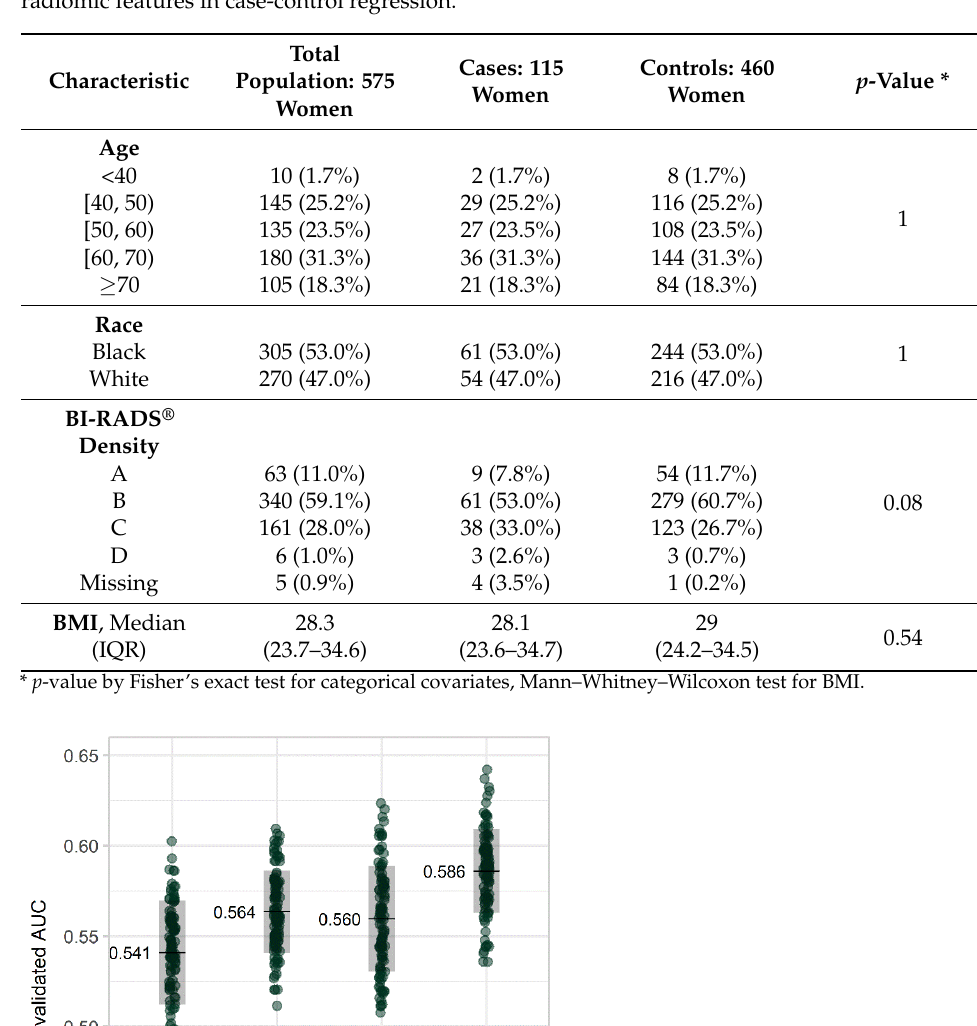
Table 2. Characteristics of participants in independent data set used to test the performance of radiomic features in case-control regression.